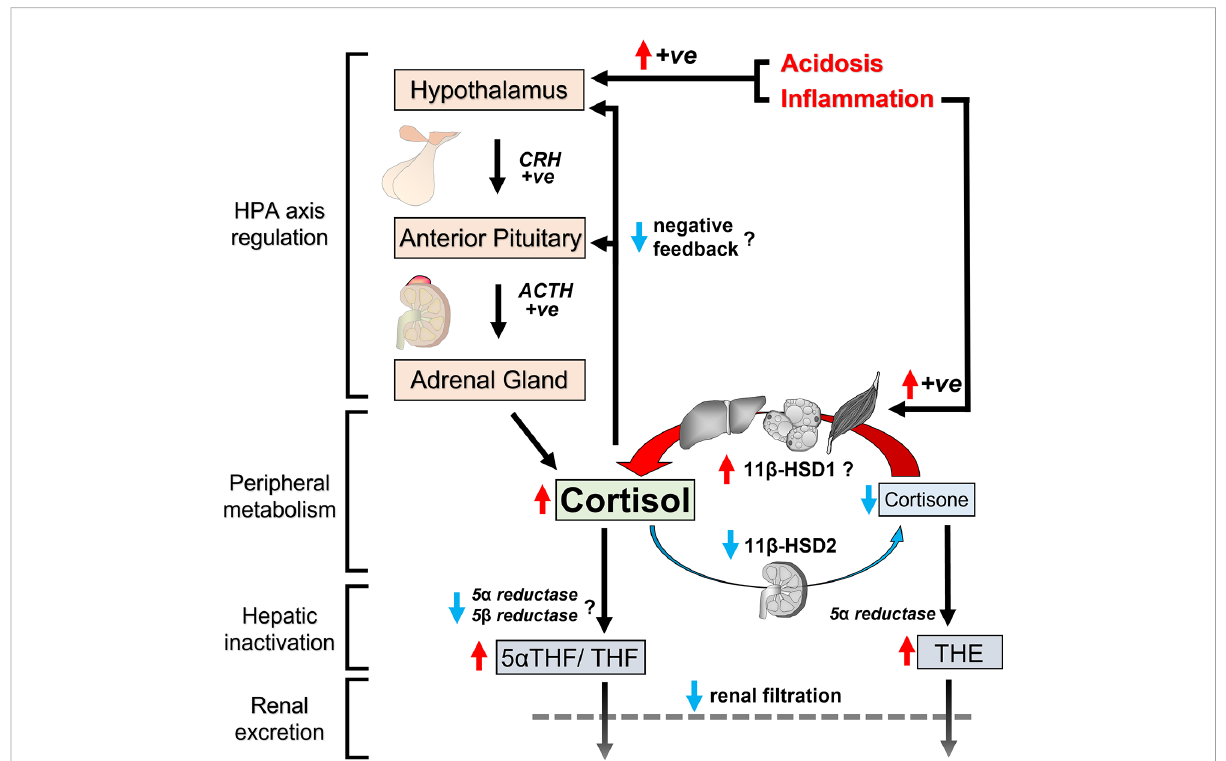
FIGURE 4 Schematic representation of changes in cortisol regulation in CKD. Cumulative exposure to circulating cortisol increases in CKD for several reasons. Clearance pathways for cortisol are impaired in CKD because reduced renal fi ltration causes accumulation of cortisol metabolites in circulation with postulated end-product inhibition of hepatic cortisol metabolism. Furthermore, loss of 11 b -HSD2 in the kidney reduces cortisol inactivation to cortisone, contributing to prolonged half-life of cortisol in circulation. Peripheral cortisol activation by 11 b -HSD1 is possibly upregulated at the same time due to increased levels of in fl ammatory cytokines. In fl ammation and acidosis also have the capacity to induce HPA axis activation. Finally, negative feedback mechanisms in the HPA axis to suppress adrenal cortisol secretion appear to be less effective in CKD. Red arrows indicate upward changes, blue arrows indicate downward changes and question marks indicate postulated changes based on indirect